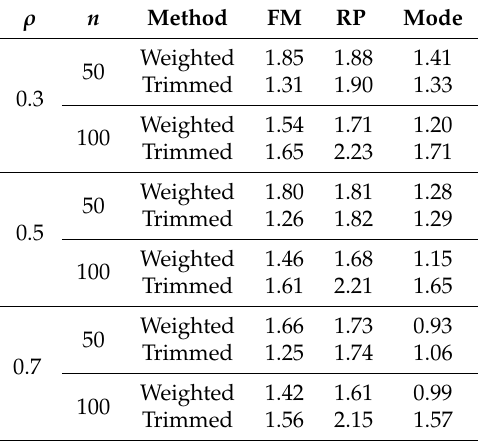
Table 3. Results for the scenarios with dependence between curves. The estimates of false alarm rate (type I error) for values of ρ between 0.3 and 0.7 are shown. ρ